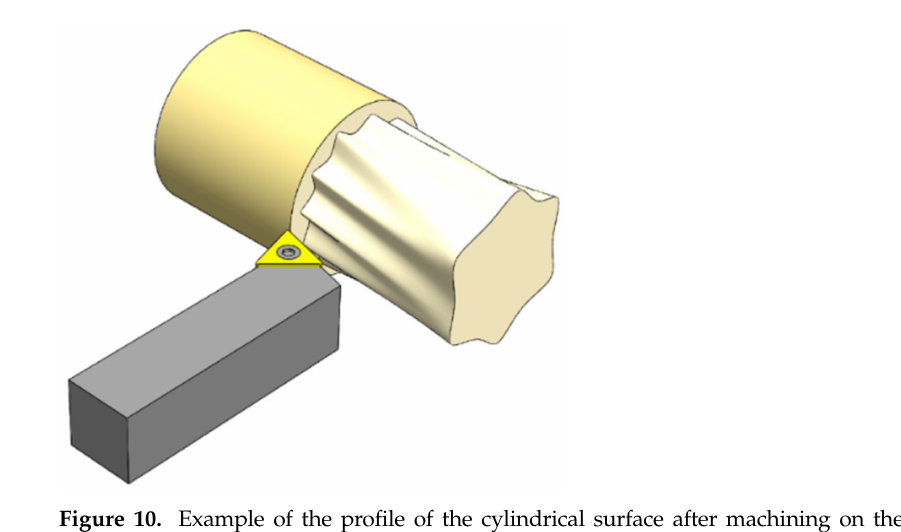
Figure 10. Example of the profile of the cylindrical surface after machining on the spindle with error